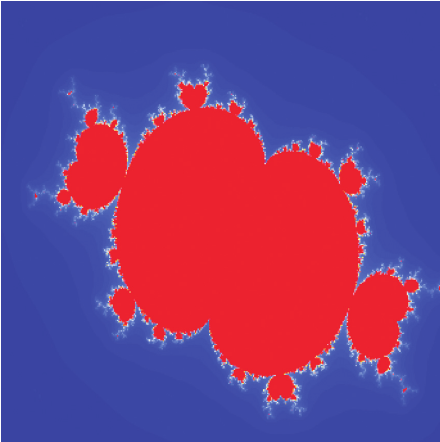
Figure 24: Cubic Mandelbrot set in